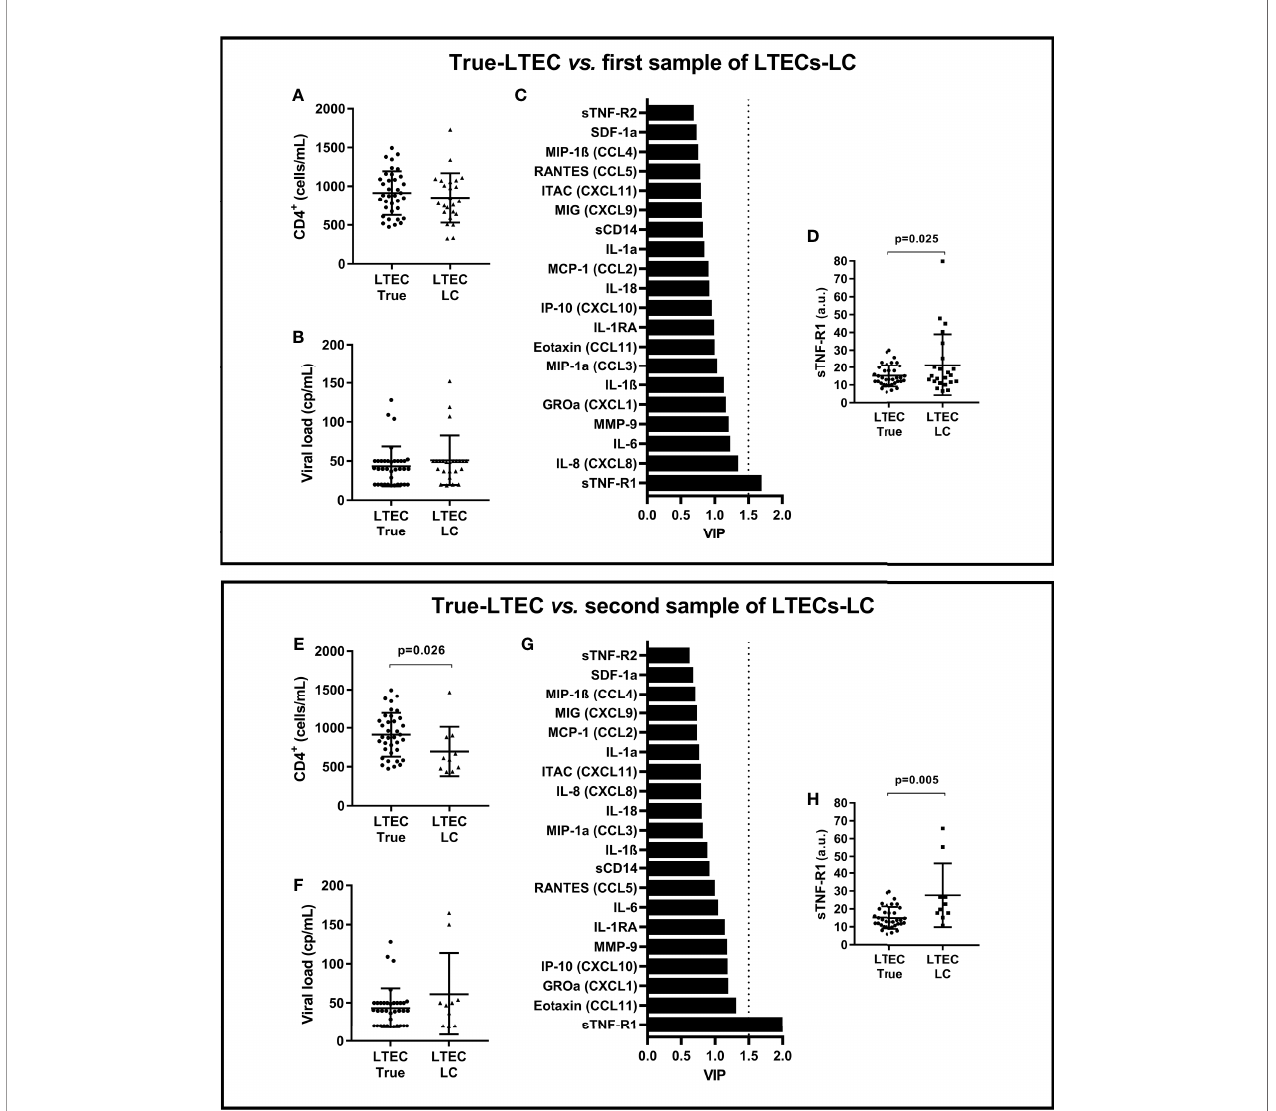
FIGURE 1 | Summary of analysis between samples of 36 true-LTECs vs. 24 LTECs-LC. (A, E) CD4+ T-cell counts. (B, F) HIV-1 viral load levels. (C, G) Variable importance in projection (VIP) score from all analyzed plasma biomarkers. (D, H) Differences in sTNF-R1 between groups. LTECs, long-term elite controllers; true- LTECs, LTEC who did not lose virological and immunological control during follow-up; LTECs-LC, LTEC who lost virological and/or immunological control during follow-up; VIP, variable importance in projection; a.u., arbitrary